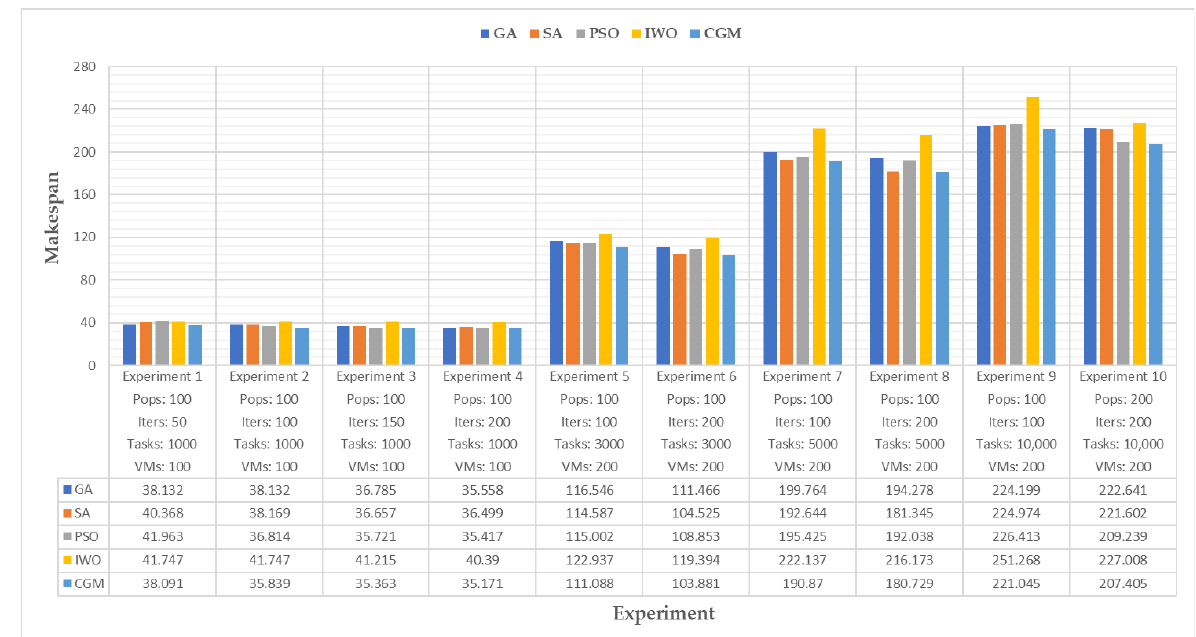
Figure 8. Evaluation results of the BoT scheduling problem.